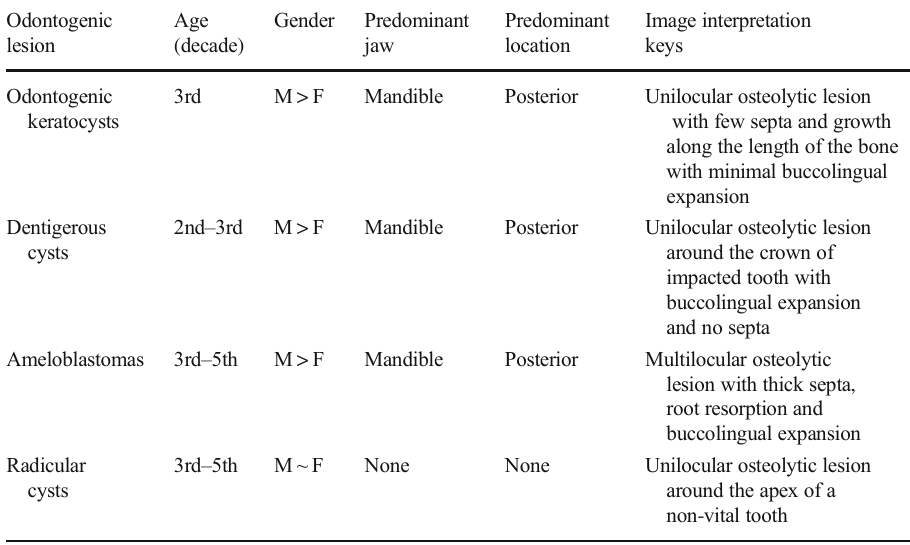
Table 1 Typical characteristics of odontogenic keratocysts (OKCs), dentigerous cysts, ameloblastomas and radicular cysts